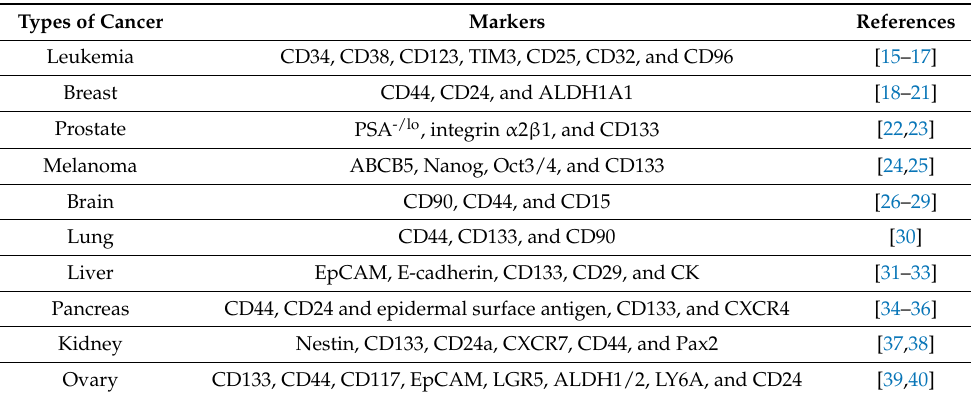
Table 1. Types of cancer in which CSCs have been detected and the main